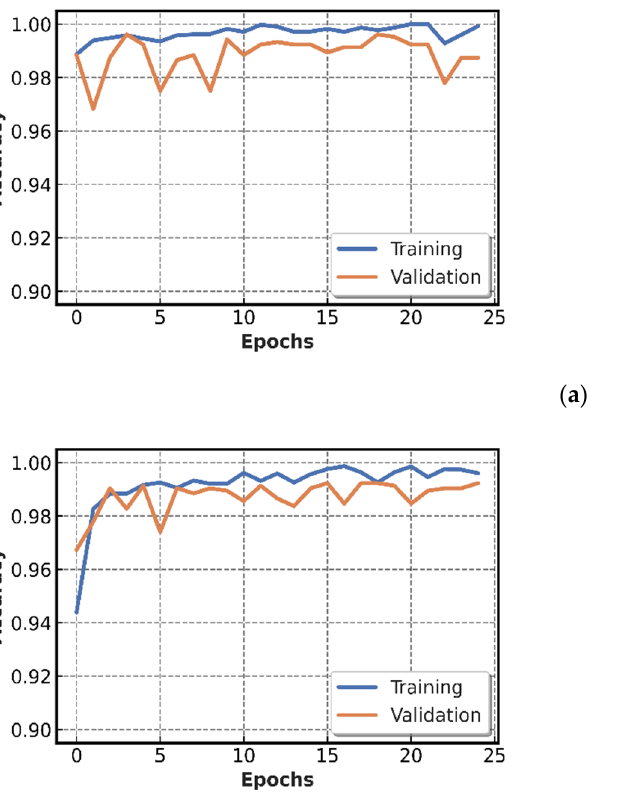
Figure 5. The accuracy and Loss of all modified pre ‐ trained models. ( a ) Xception model, ( b ) Incep ‐ tion V3 model, ( c ) InceptionResNet V2 model, ( d ) ResNet50 V2 model, ( e ) MobileNet V2 model, ( f ) Dense ‐ Net201 model.